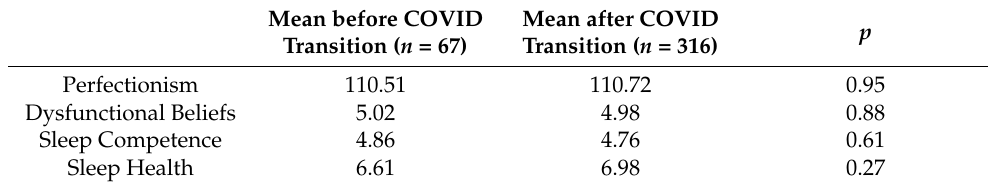
Table 4. Mean differences in participant responses before and after the transition to virtual learning due to COVID–19.